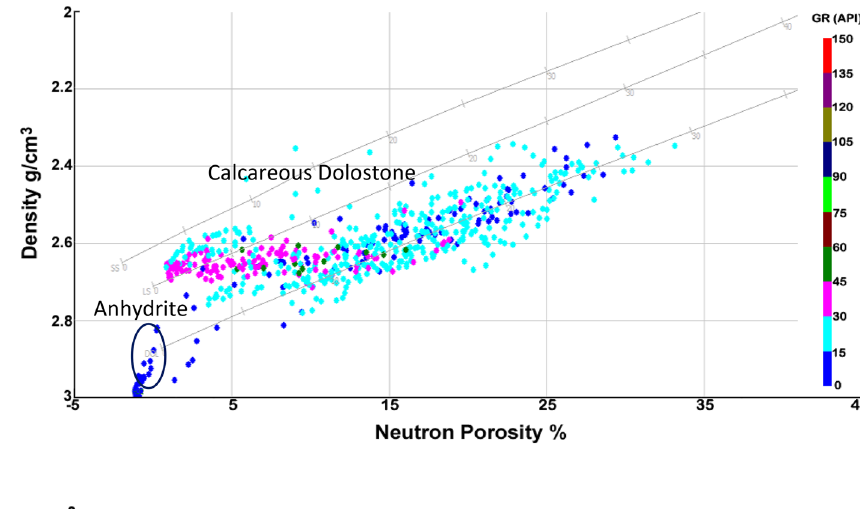
Fig. 6 Neutron porosity (Ø versus bulk density ( ρ b ) cross- plot of A3 well